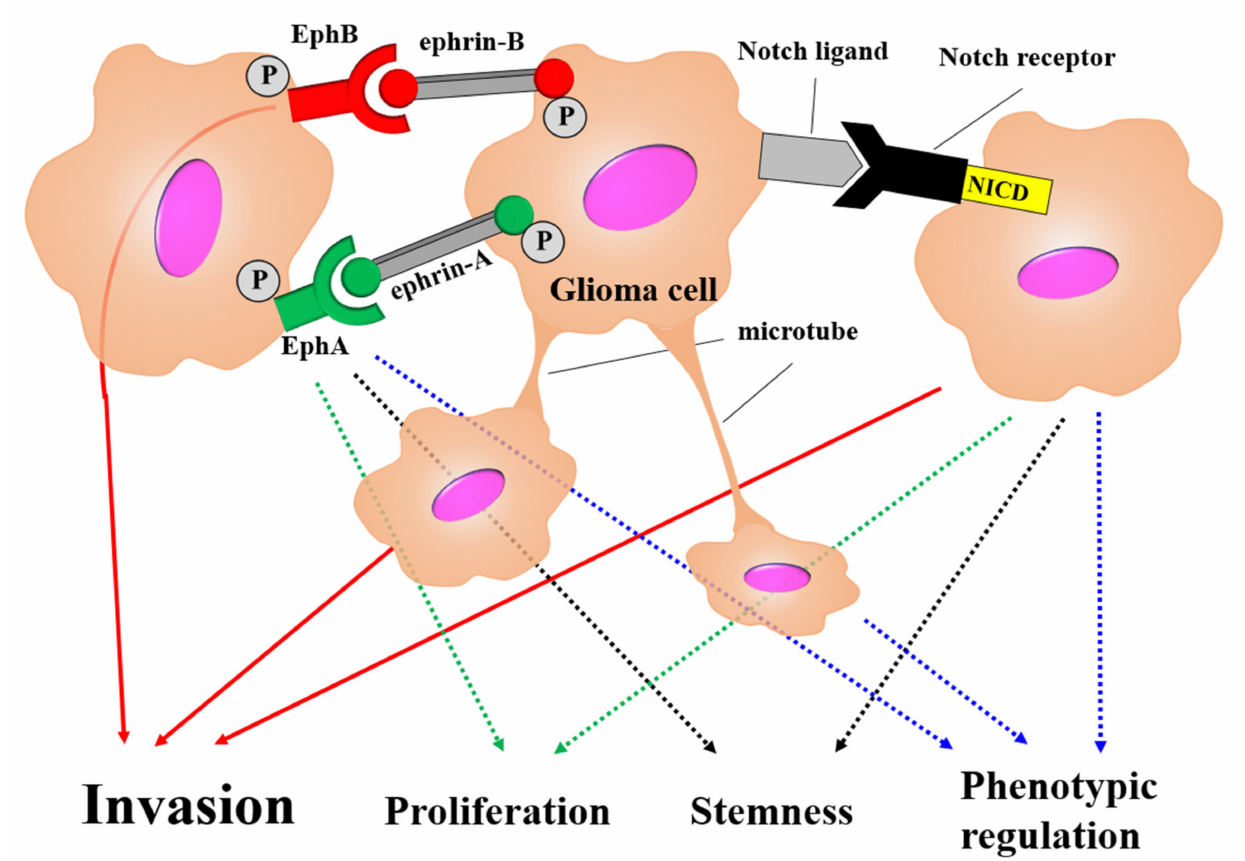
Figure 5. Cell-to-cell systems schema related to the glioma microenvironment. Glioma cells form the tumor environment, developing microtube networks, erythropoietin-producing human hepatocellu- lar receptor (Ephs)–ephrin pathways, and Notch signals. Cell-to-cell systems are mainly associated with invasion (red line), proliferation (green dotted line), stemness maintenance (black dotted line), and phenotypic regulation (blue dotted line) in glioma cells. Invasion ability is acquired from the microtube network, EphB–ephrin-B pathway, and Notch signaling. Cell proliferation and stemness maintenance are involved in the ephrinA–ephrinA pathway and Notch signaling. The glioma pheno- type is regulated by the microtube network, EphA–ephrinA pathway, and Notch signaling. P in a grey circle indicate the phosphorylation. Abbreviation: NICD; notch intracellular